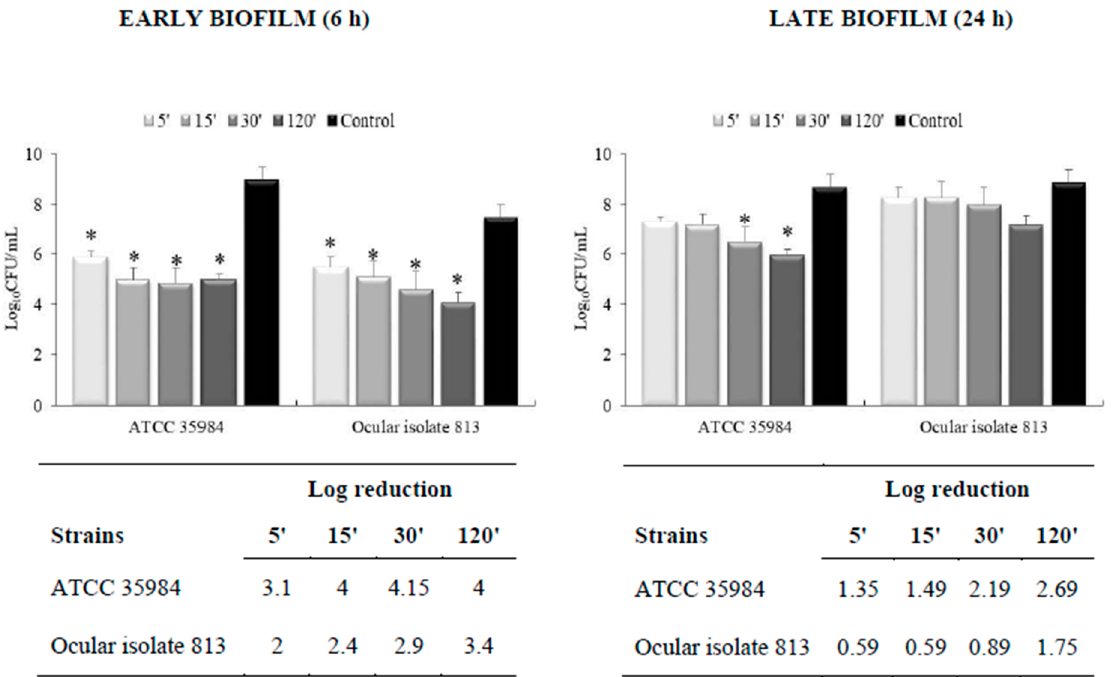
Figure 2. Quantitative measurement of S. epidermidis biofilm-embedded cells after treatment with CST. Data are expressed as means ± SD of three independent experiments carried out in triplicate and relative Log reduction. *, p -value < 0.05 shows the statistical difference between treated groups and control